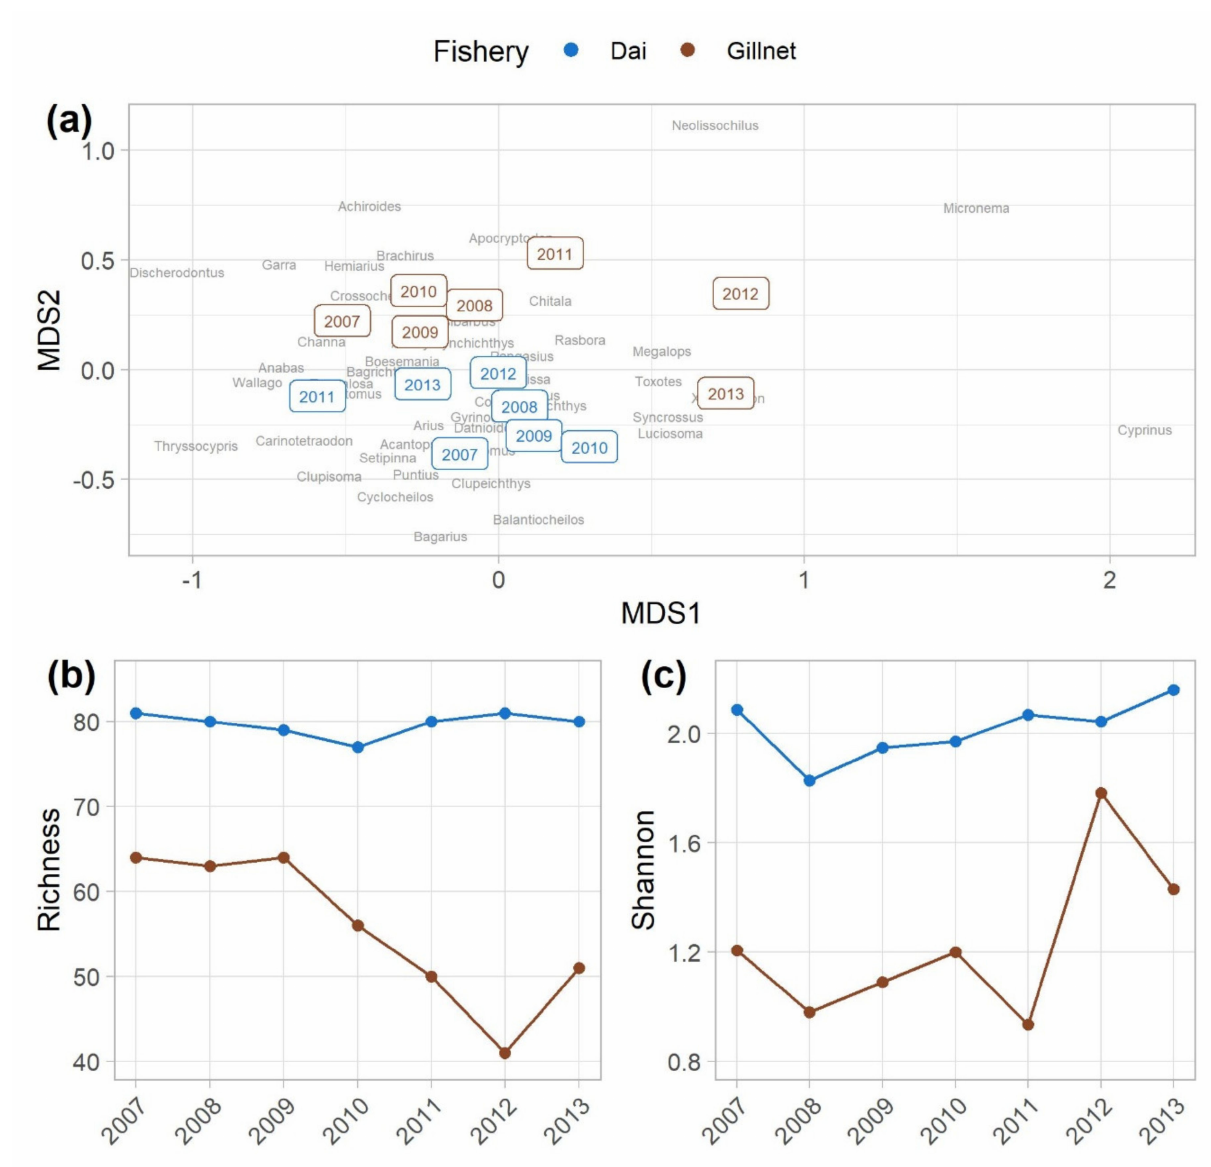
Figure 3. ( a ) Non-metric multidimensional scaling plot visualizes that the Dai fishery and gillnet fishery capture different communities of fish. The Dai fishery ( b ) captures a greater number of species and ( c ) has a higher Shannon index annually than the gillnet